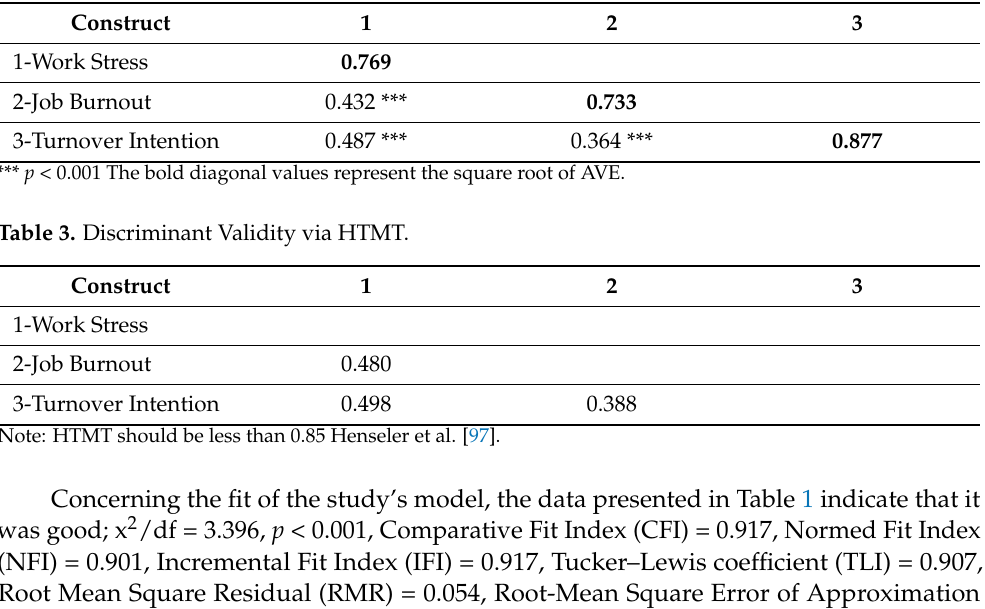
Table 2. Constructs’ Correlation and Discriminant Validity Based on Fornell–Larcker Criterion.